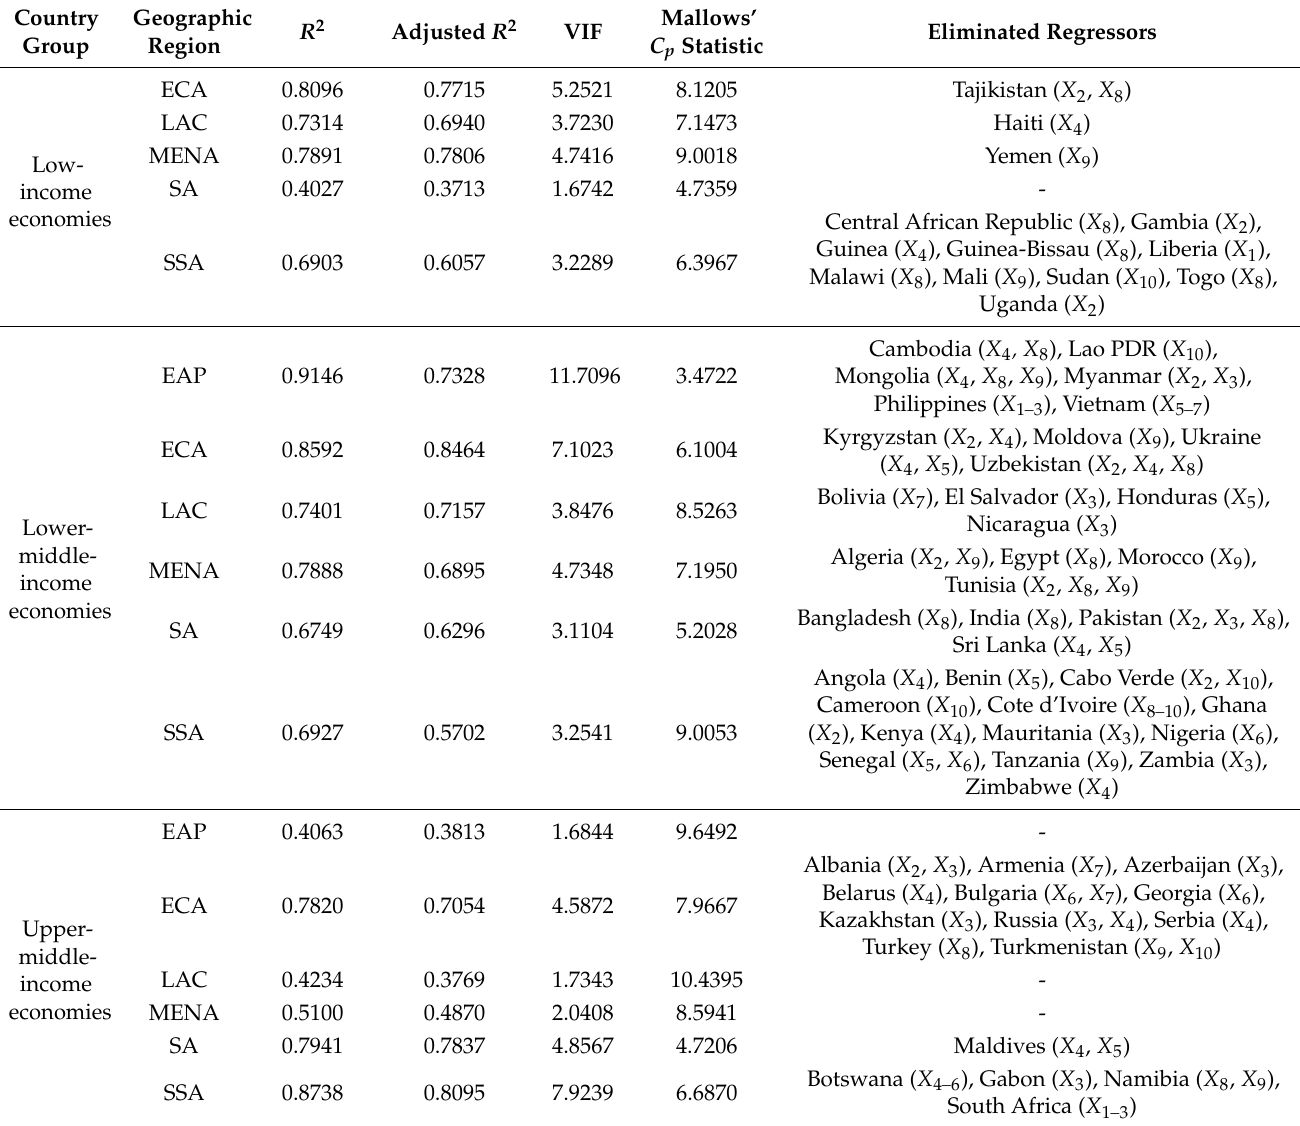
Table 6. Collinearity check and selection of the best